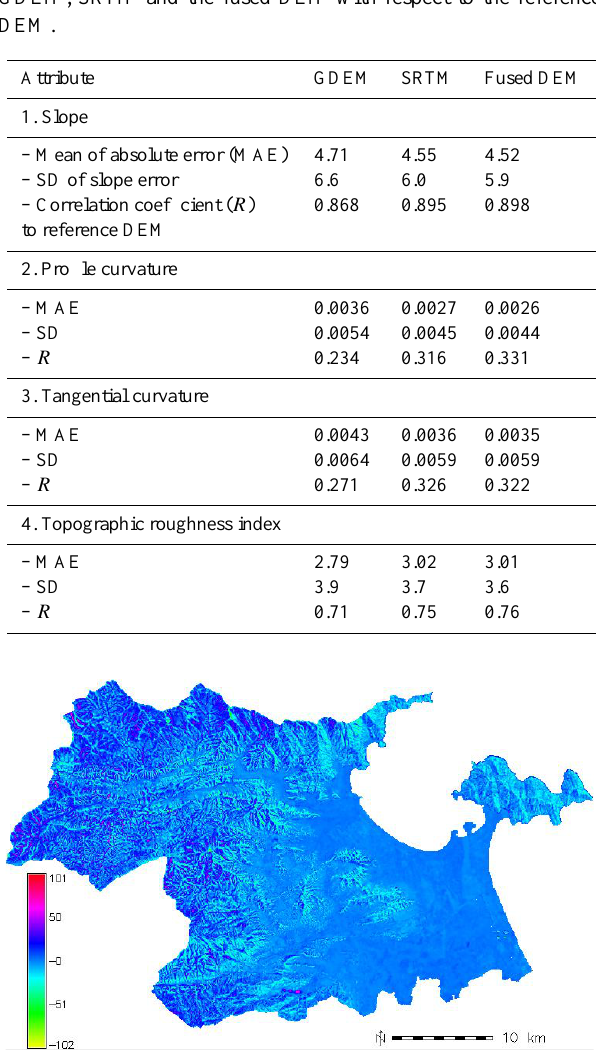
Table 6. General statistics for the error of GDEM, SRTM and the fused DEM. Unit: m.